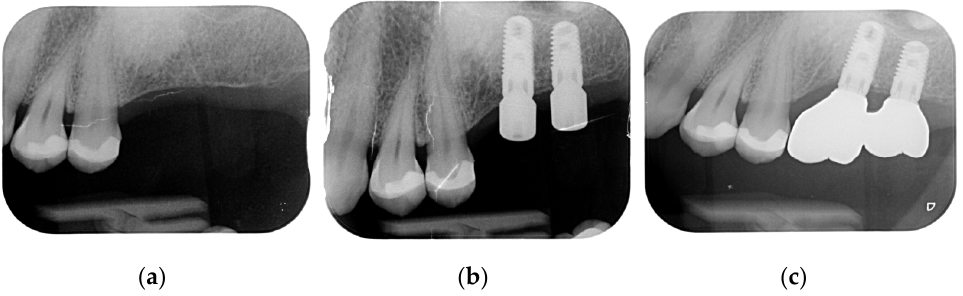
Figure 9. Juxta-gingival view of the surgical site: ( a ) preoperative view; ( b ) implants’ placement; ( c ) prosthetic on implants.